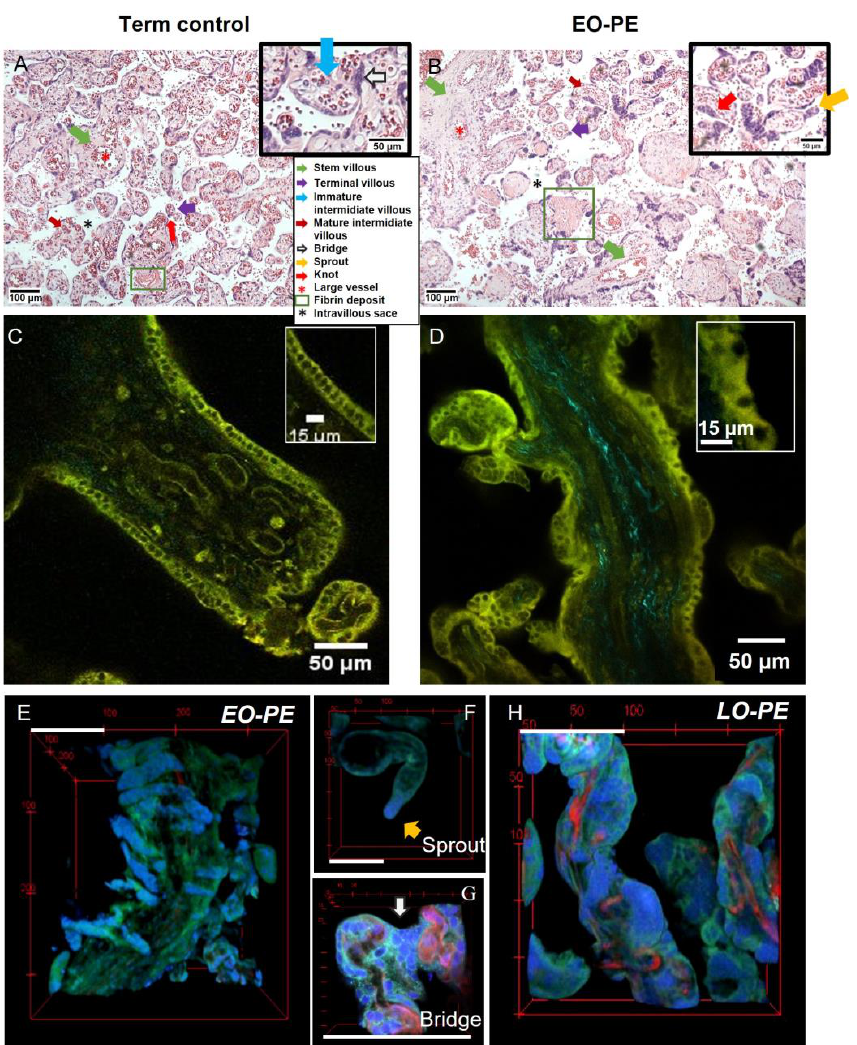
Figure 1. H&E-stained villous tissue of ( A ) term control and ( B ) pre-eclampsia placenta. Villous tissue is visible in pink, and white regions between villi represent the intervillous space. Green arrows point to stem villi (diameter 100–3000 µ m) which contain large and centrally located arteries. The blue and dark-red arrow points to an immature intermediate villous or mature intermediate villous, respectively. Purple arrows indicate terminal villi (diameter 30 – 80 µm). Regions with fibrin depositions are indicated with squares. Nuclear clusters (bridges (white arrow inset ( A ), knots (red arrow) or even sprouts (yellow arrow inset ( B ))) are apparent on term control placenta and excessively present on PE placenta (insets ( A ) and ( B )). ( C,D ) Placental tissue imaged with MPM without fluorescent labelling. ( C ) The epithelial trophoblast layer in term control placenta is organised, while ( D ) EO-PE placenta had disorganised epithelial trophoblast. ( E – H ) Placental tissue stained for blood vessels (red) and nuclei (blue) to visualise the different 3D shapes of nuclear clusters. ( E ) Wave-like knots on a stem villous from EO-PE placenta. ( F ) The 2nd trimester placenta illustrating a typical sprout and its 3D conformation. ( G ) Nuclear accumulations that form a bridge typically seen in term control placenta. ( H ) LO-PE placenta with various knot shapes, ranging from elongated surface extending shapes to small round protruding knots. Green — villous tissue, blue — nuclei, cyan — collagen, red — vessels. Scale bars in ( E – H ) —100 μm.